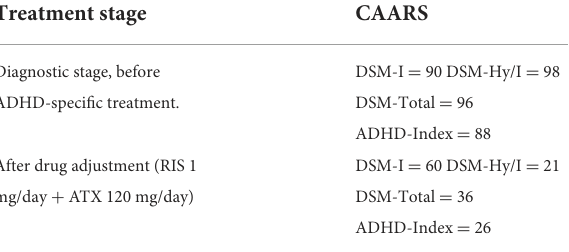
TABLE 1 The patient’s score on CAARS-S (in percentile rank). Treatment